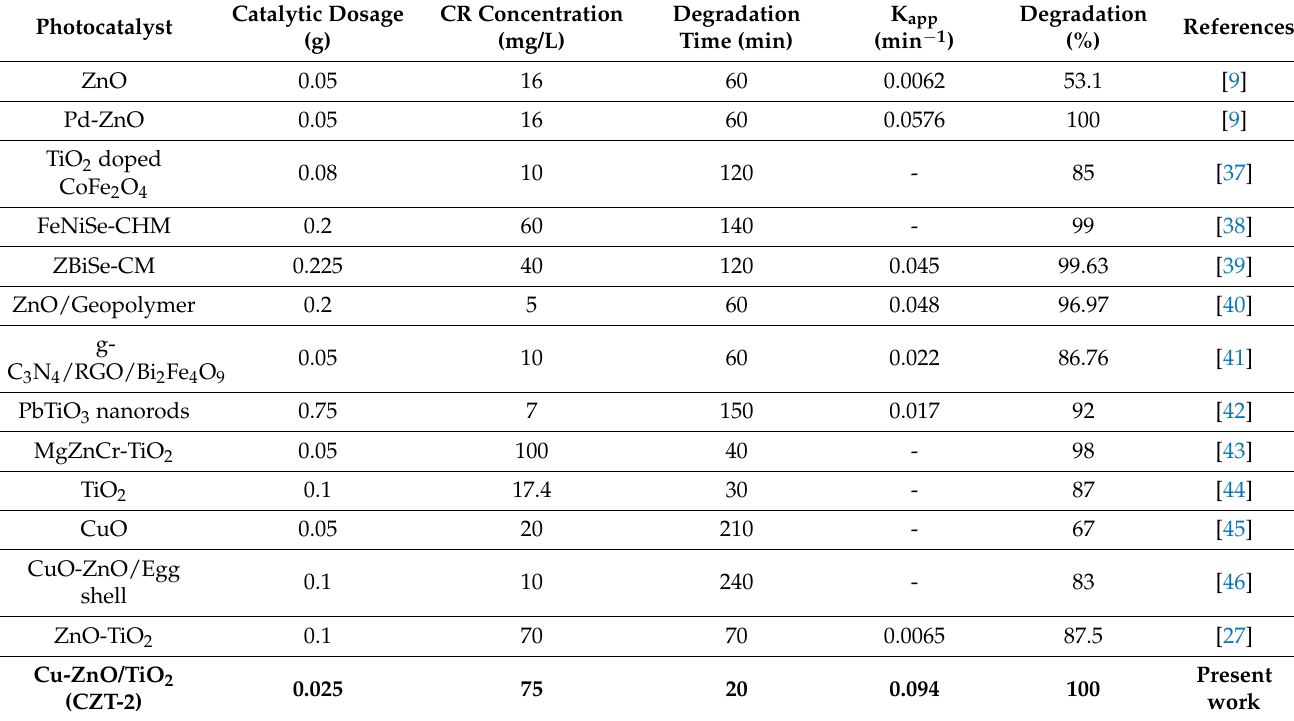
Table 3. Summary of the photocatalytic performance of different catalysts used for CR